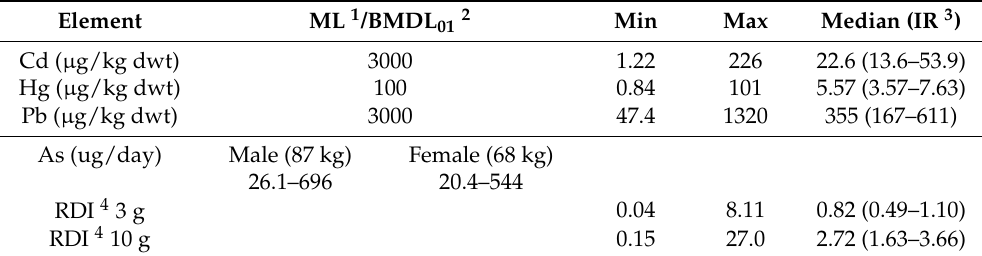
Table 5. Toxic trace element content in Spirulina